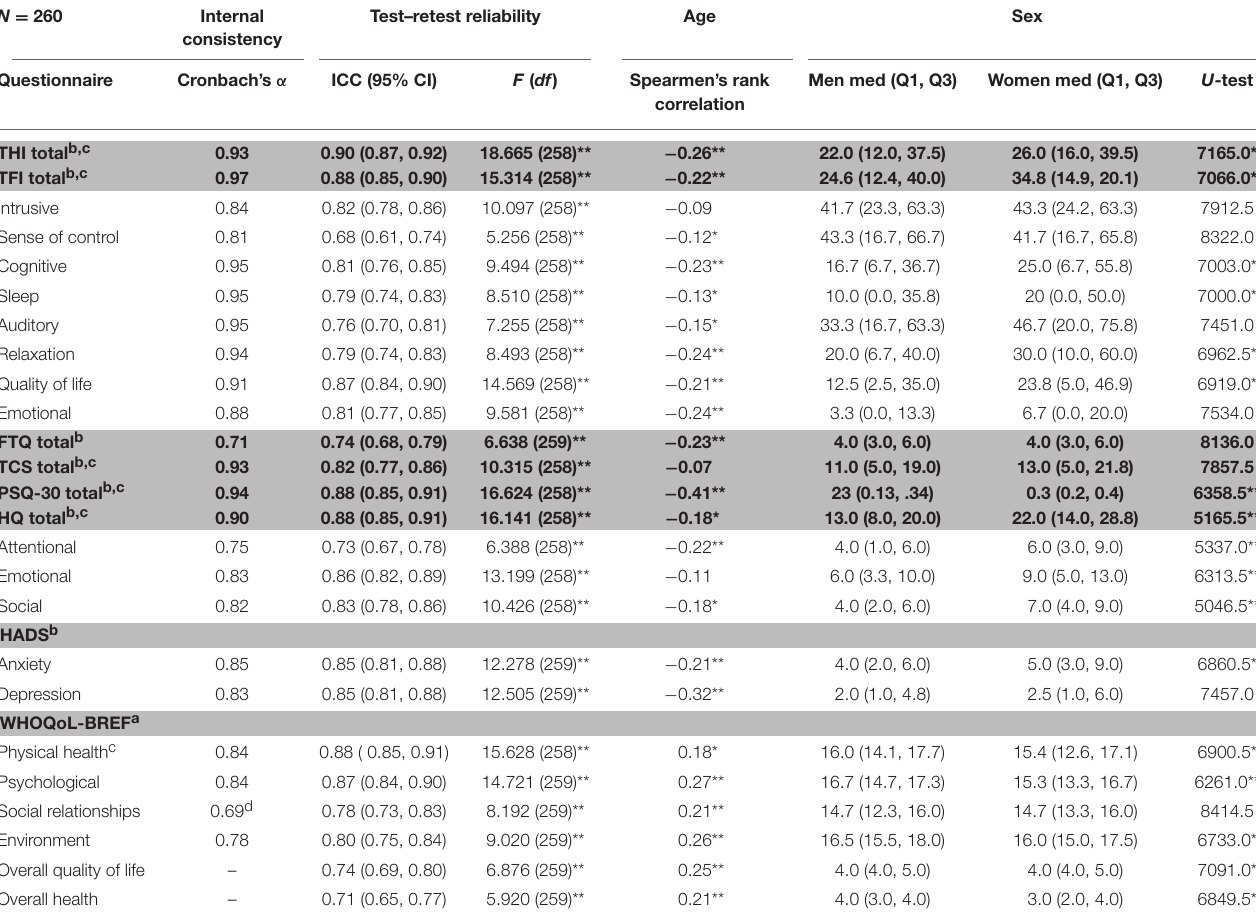
TABLE 4 | Internal consistency and test–retest reliability of tinnitus-related questionnaires and relations with age and sex. N =